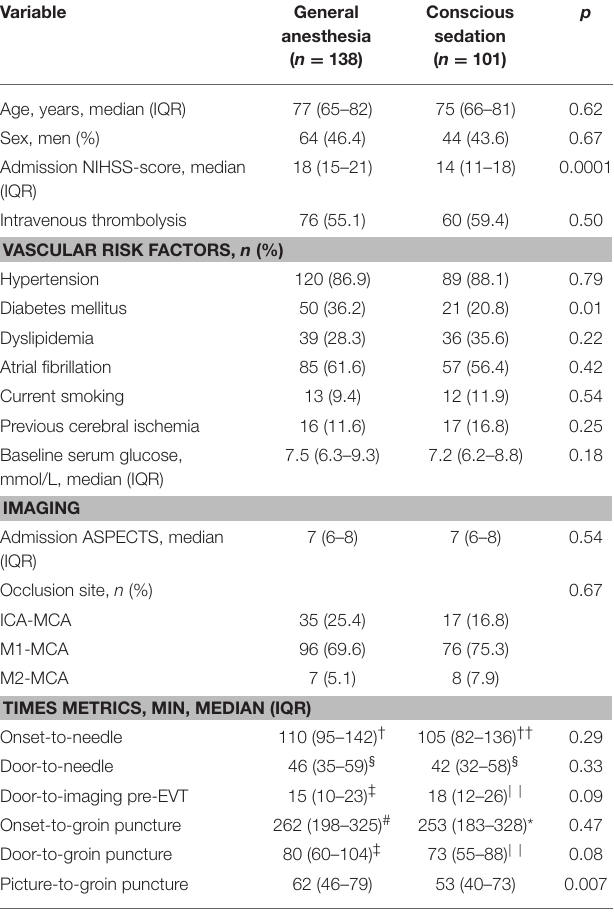
TABLE 2 | Clinical and imaging characteristics for general anesthesia and conscious sedation groups.